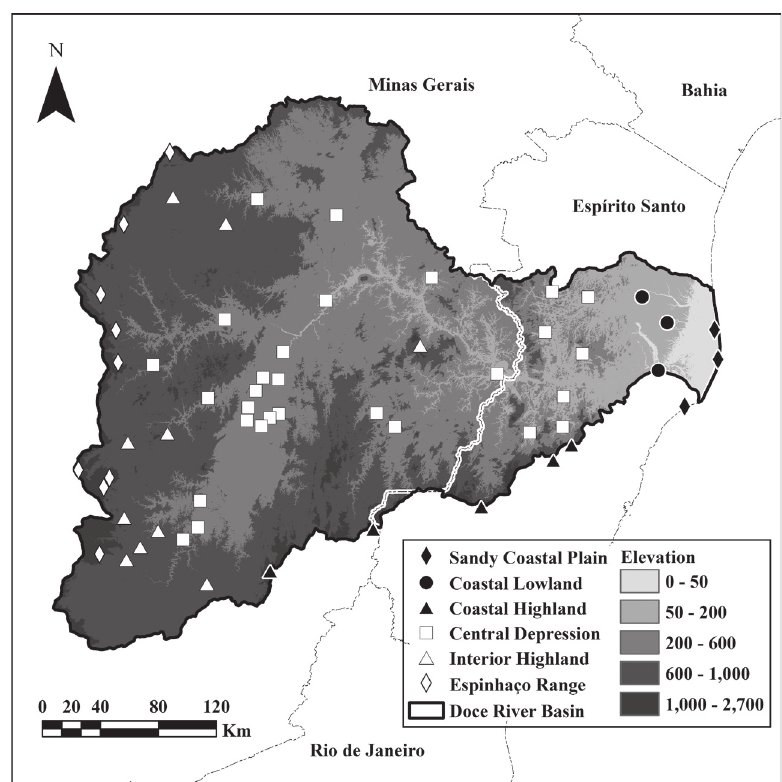
Figure 1 - Location of the Doce River Basin encompassing portions of the states of Minas Gerais and Espírito Santo in southeastern Brazil. Sites of the six subregions adopted in this study are